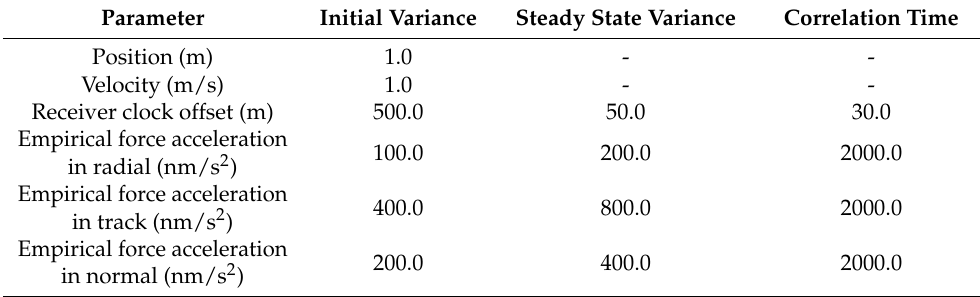
Table 3. Settings of the process-noise-related